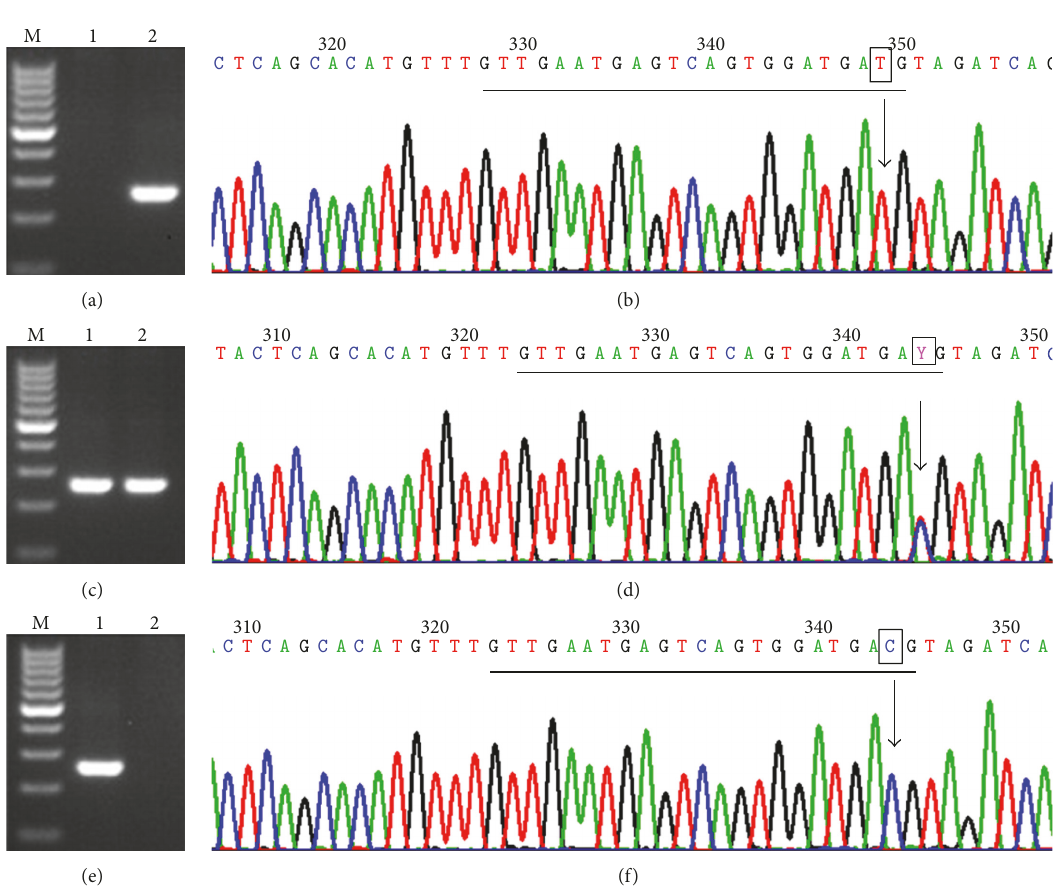
Figure 1: Representative illustrations of genotyping data and sequencing chromatography results. PCR product from the C allele template (lane 1) and the amplified fragment from the T allele-specific DNA using the on/off switch (lane 2). (a, c, and e) are the relevant genotypes confirmed by Sanger sequencing. The corresponding genotypes are CC, CT (Y), and TT as indicated with the box. M, marker.